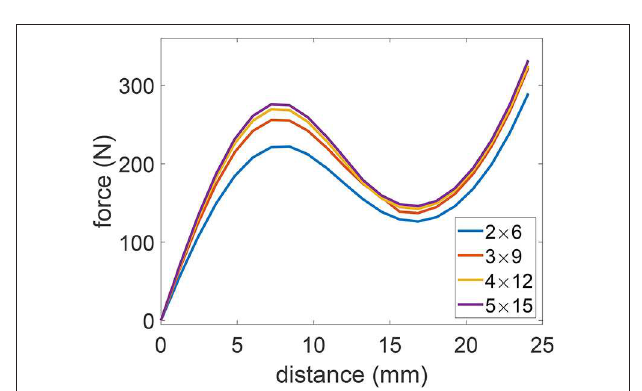
FIGURE 4 | Force-displacement diagrams for different number of elements along the ligament width and height, showing converging